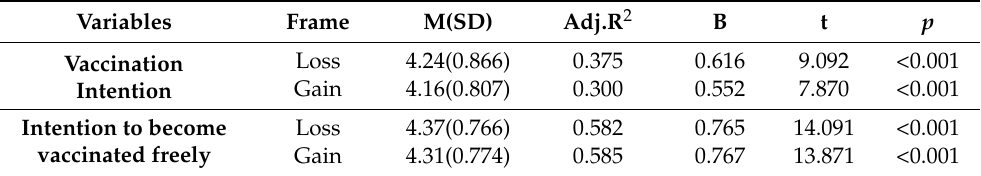
Table 6. Linear regression analysis of vaccination intention under information